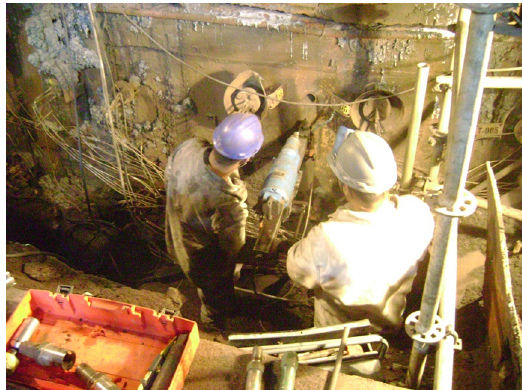
Figure 2. Drilling the furnace metal shell to collect the drill core sample.